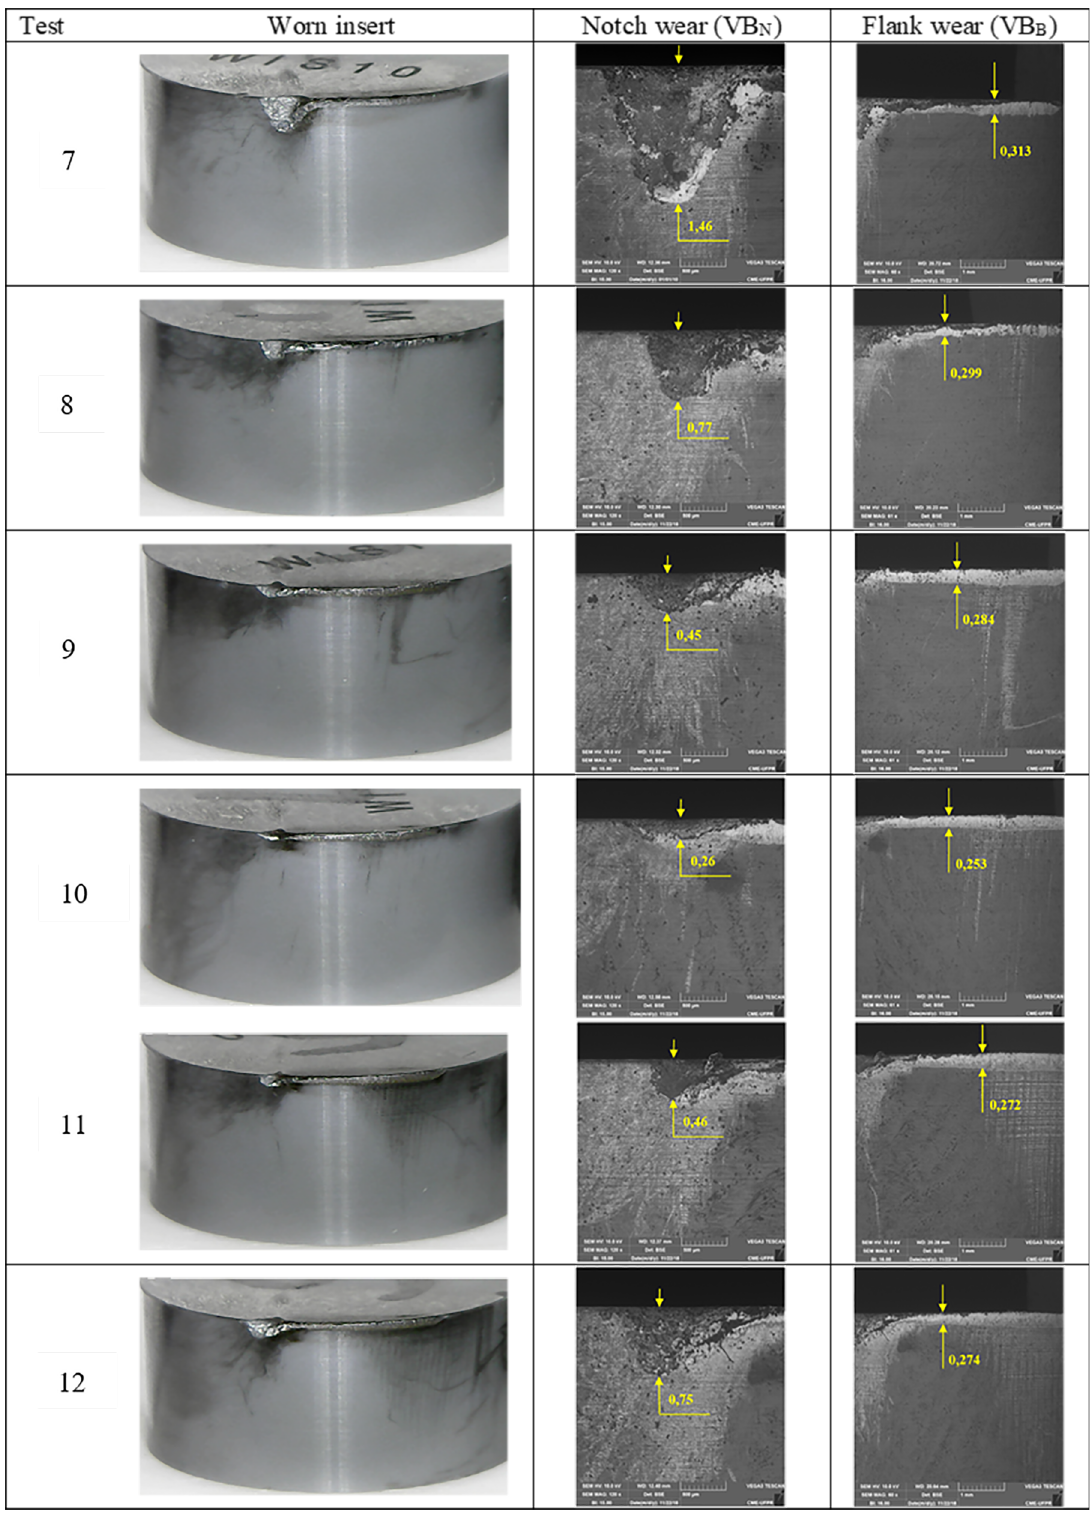
Figure 3. Worn SiAlON